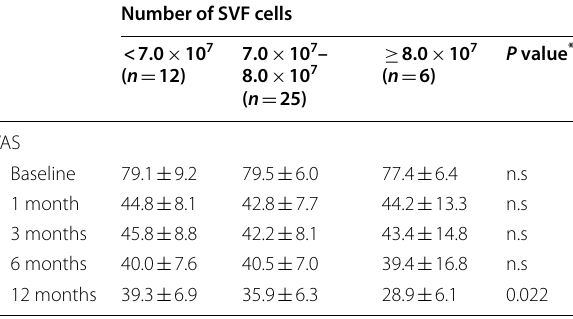
Data are presented as means SVF Stromal vascular fraction, VAS Visual analogue scale * Kruskal–Wallis test